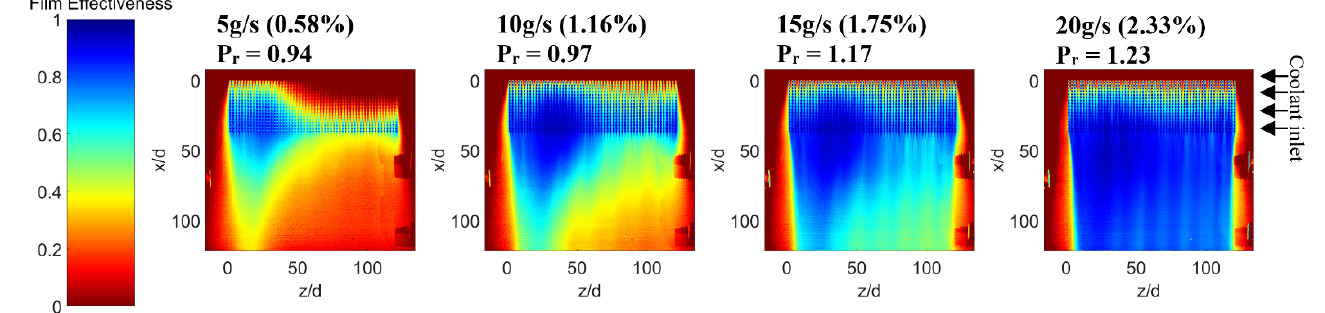
Figure 5. Film effectiveness of Panel 4 at different coolant mass flow rates (mass